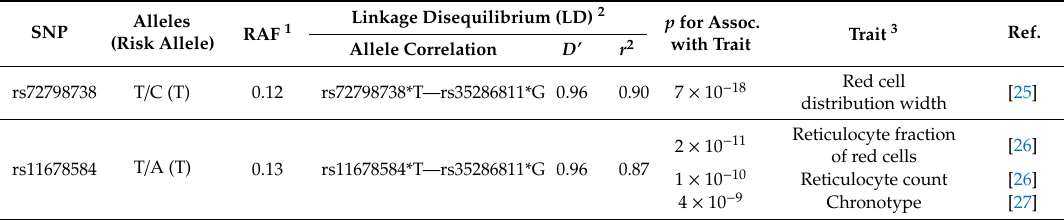
Table 4. BIRC6 rs35286811 proxies are associated with independent traits. 1 RAF: risk allele frequency in non-Finnish Europeans [28]. 2 Linkage disequilibrium (LD) D’ is an indicator of allelic segregation of two genetic variants and r 2 is a measure of correlation of these variants. LD values refer to European population. 3 Traits reported by GWAS.